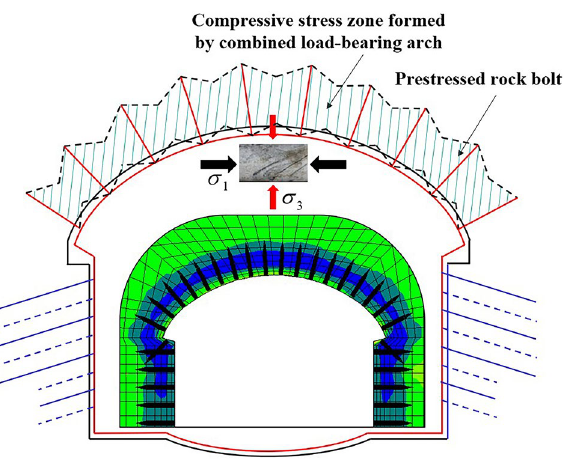
Figure 6. Combined load-bearing